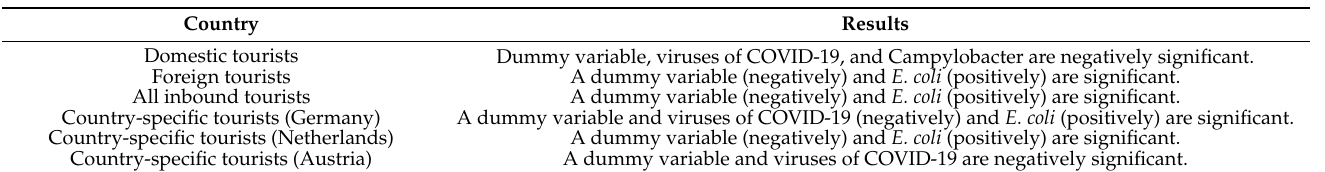
Table A2. The robustness of the research, 156 observations, 2000 = 100 base indices, period 2008–2020. Country